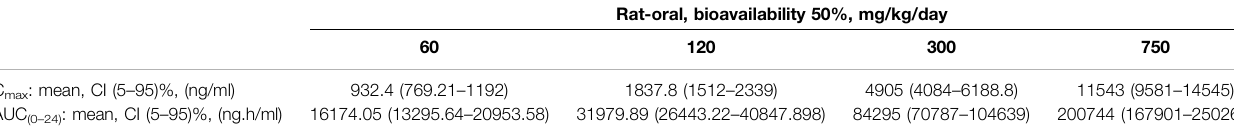
TABLE4| Impactofthedermaldeliveryvalueontheestimated C max ofhomosalateafterasingledermaladministration.Foreachscenario,asingledoseof10%homosalate was applied to the whole-body surface (17500 cm 2 ) at 103 μ g/ cm 2 / day. The values for the Day 1 kinetics.